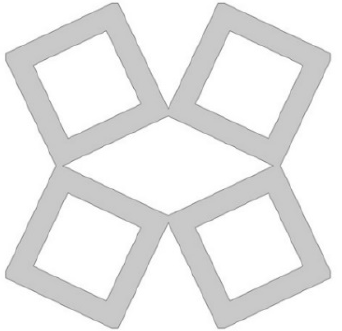
Figure 4. The obtained unit cell for d 1 = 0.65.